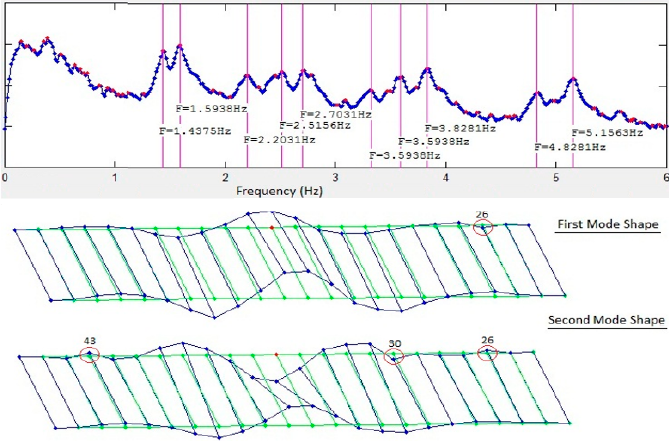
Figure 12. First solution set after the first iteration of the algorithm.